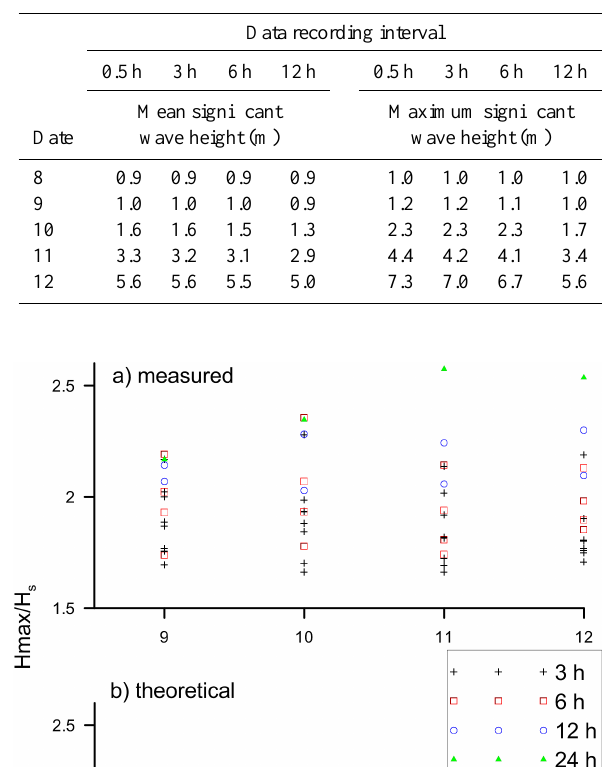
Table 3. Mean and maximum value of significant wave height for different data recording intervals during 8–12 October 2013.